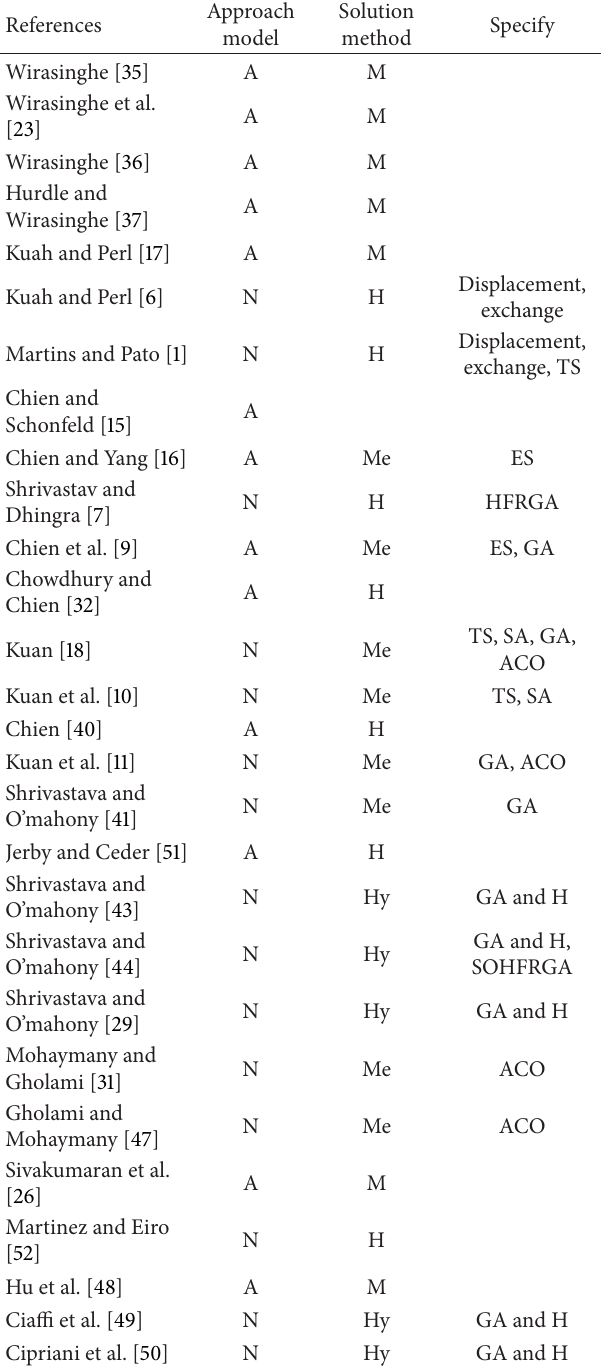
Table 4: Approaches and solution methods in the literature.